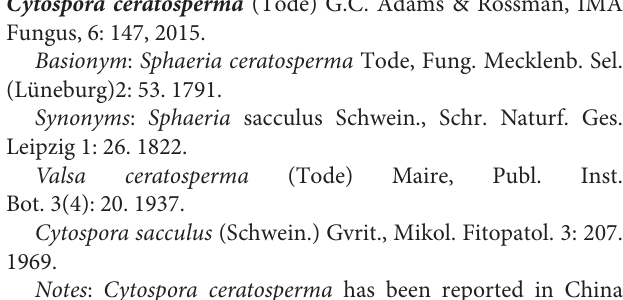
circular to ovoid, disc dark brown, 340–610 µ m ( ¯ x = 480 µ m, n = 30) in diam. Ostiole unconspicuous,